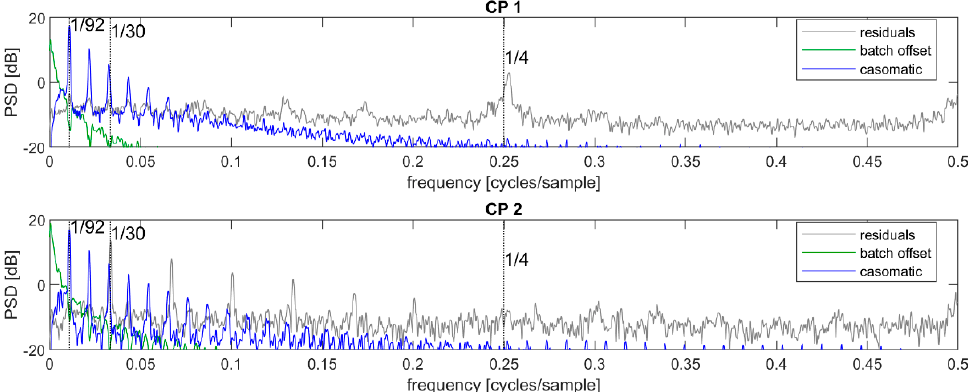
Figure 4. Top: power spectral density of initial decomposed signal at control point CP1; bottom: same for signal at CP2—both from 2019. The unit is in the logarithmic scale of decibel (dB) which implies a factor 10 for each increase by 10 dB.